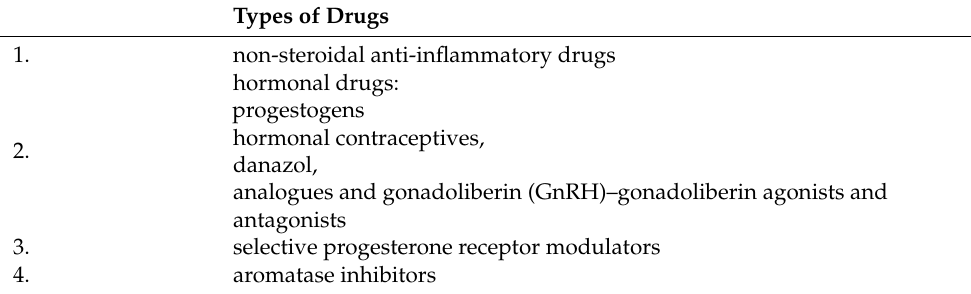
Table 4. Groups of medicines used in the treatment of